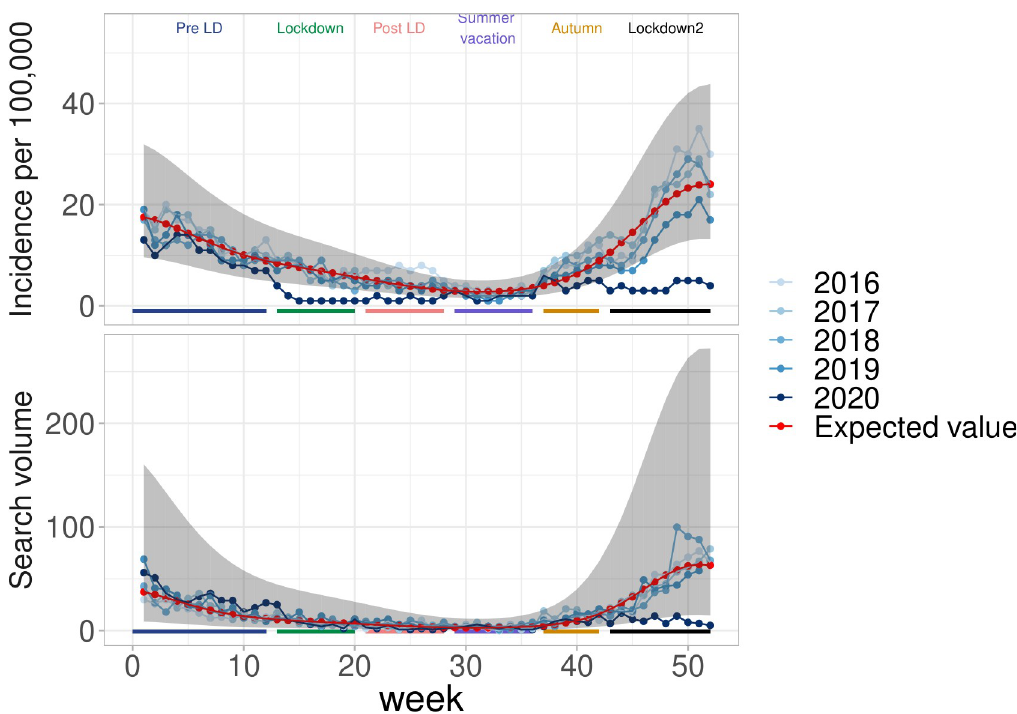
Fig 3. Bronchiolitis in France during the COVID-19 pandemic. (top) Incidence in general practice (IQVIA) and (bottom) search query volume.